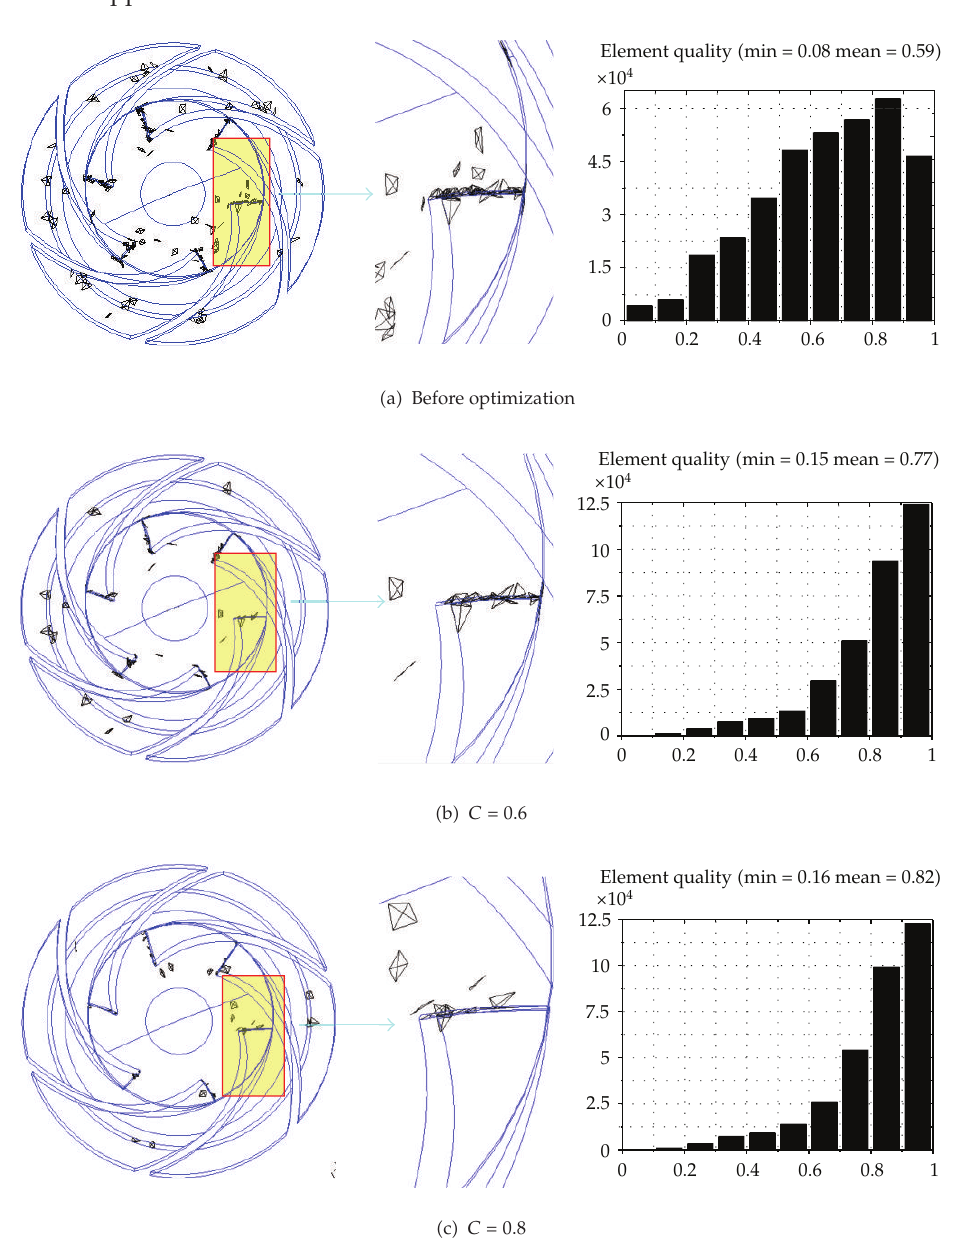
Figure 5: Distribution of poor quality